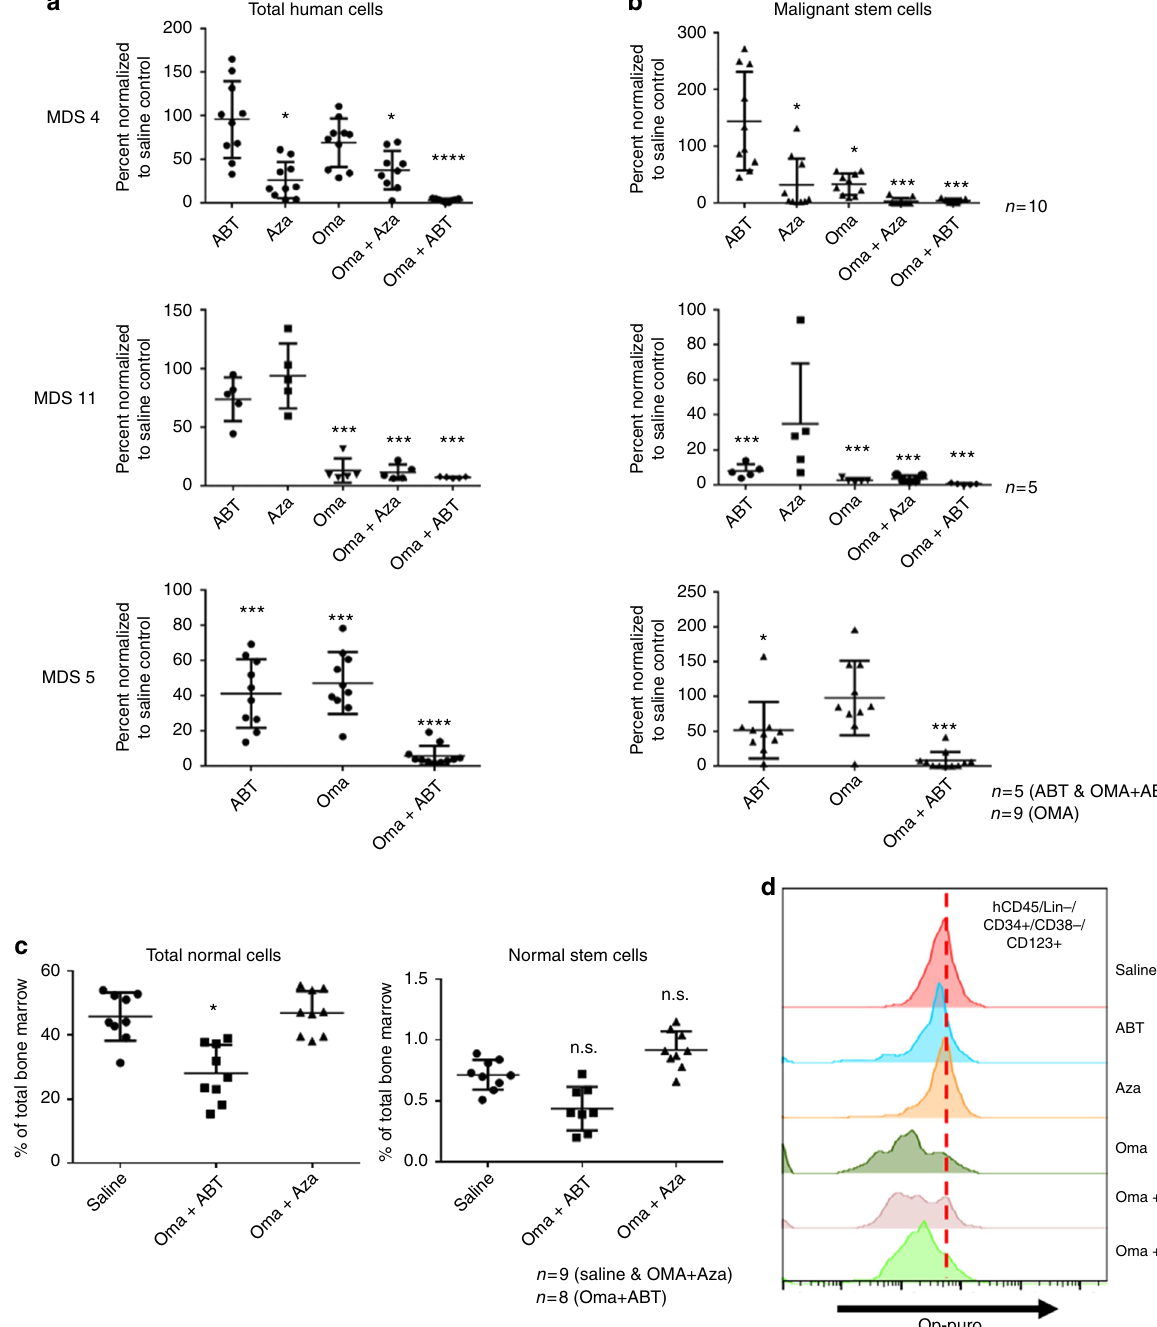
Fig. 7 In vivo treatment of primary human MDS xenografts with omacetaxine mepesuccinate, ABT-199, and azacitidine. High-risk MDS patient bone marrow samples from three independent patients ( a , b ) or normal human CD34 + cells ( c , d ) were used to establish xenografts in NSG-S mice. After engraftment (~8 weeks post-transplant), animals were dosed daily with omacetaxine (Oma) alone (0.75 – 1.0 mg/kg) or in combination with ABT-199 (ABT) (50 – 100 mg/kg) or azacitidine (Aza) (1.5 – 3 mg/kg) for two weeks. Following treatment, human cell burden was measured by fl ow cytometry using antibodies speci fi c to human CD45, lineage cocktail, CD34, CD38, and CD123. Graphs re fl ect total numbers of positive cells normalized to vehicle control animals. a Bulk human MDS cells (hCD45 + ). b MDS stem cells (hCD45 + /Lin − /CD34 + /CD38-/CD123 + ). c Total normal human cells (hCD45 + ) and normal stem cells (hCD45 + /Lin − /CD34 + /CD38 − ). Graphs re fl ect numbers of positive cells normalized to vehicle control animals or percentage of total bone marrow. * indicates p < 0.05; *** indicates p < 0.001 ( t -test) error bars are S.D. d Representative OP-puromycin labeling of xenograft bone marrow cells following treatment with single and combination agents (gated on the hCD45 + /Lin − /CD34 + /CD38 − /CD123 +